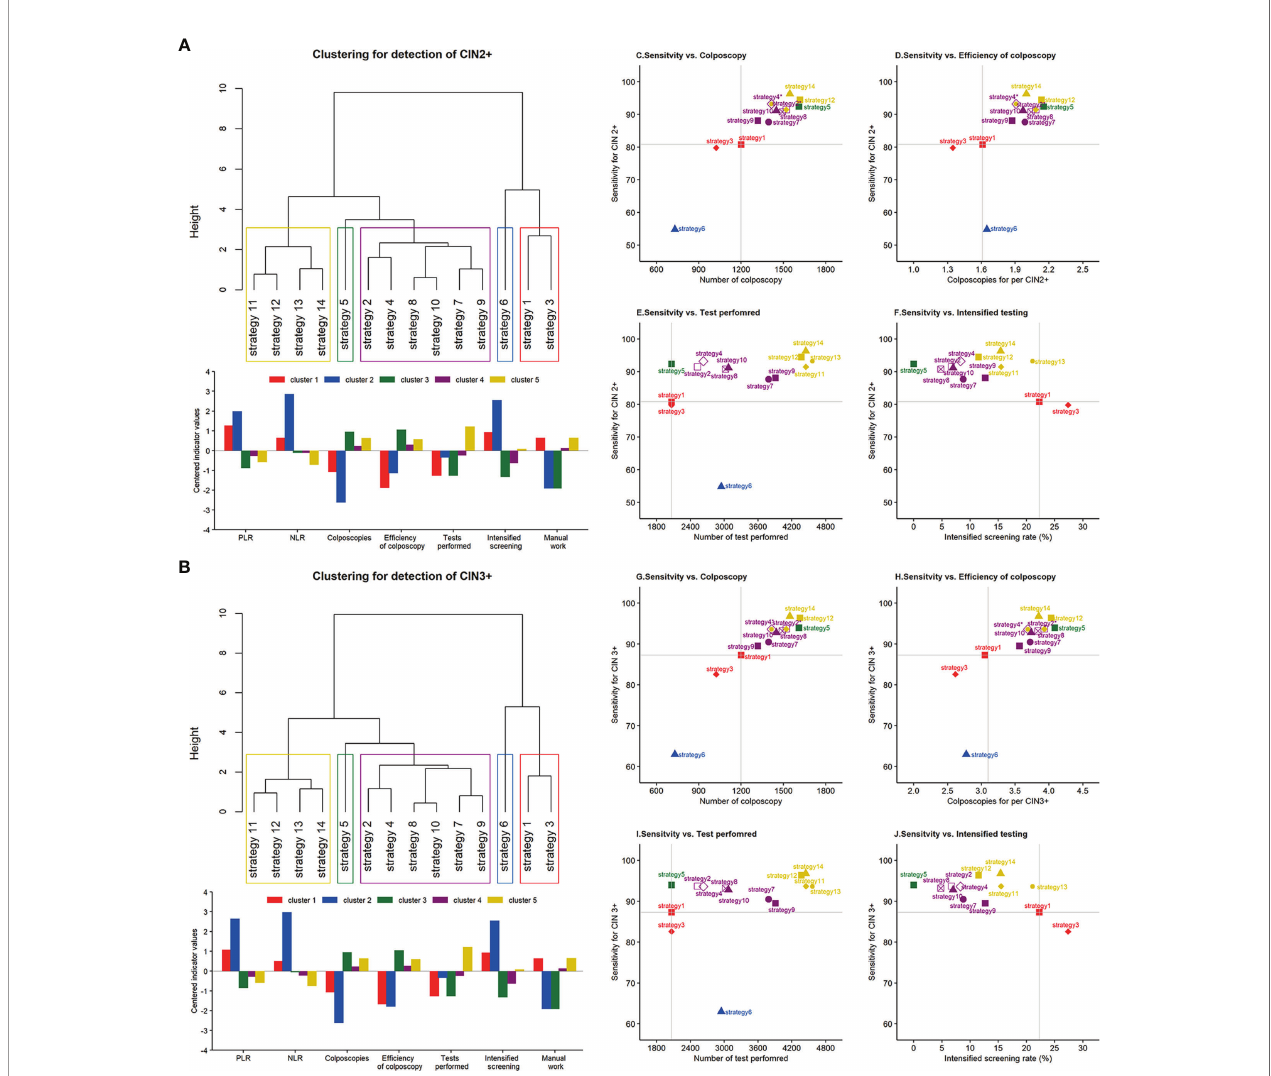
FIGURE 3 | Clustering dendrogram and characterization of different screening strategies for the detection of (A) CIN2+ and (B) CIN3+. Scatterplot between the sensitivity for CIN2+ and (C) the number of colposcopies, (D) colposcopies to detect 1 case, (E) the number of tests performed, and (F) intensi fi ed screening rate. Scatterplot between the sensitivity for CIN3+ and (G) the number of colposcopies, (H) colposcopies to detect 1 case, (I) the number of tests performed, and (J) intensi fi ed screening rate. Note: *strategies 2 and 11, strategies 4 and 13 are at the same coordinates. PLR, positive likelihood ratio; NLR, negative likelihood ratio; CIN, cervical intraepithelial